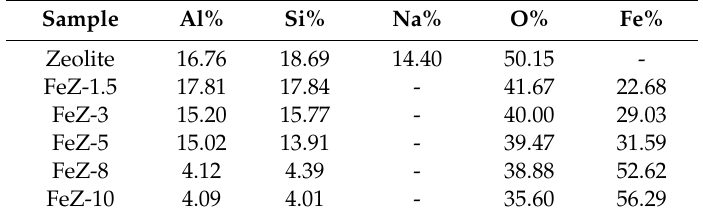
Table 1. Composition of bare zeolite and FeZ composites as determined by EDX.